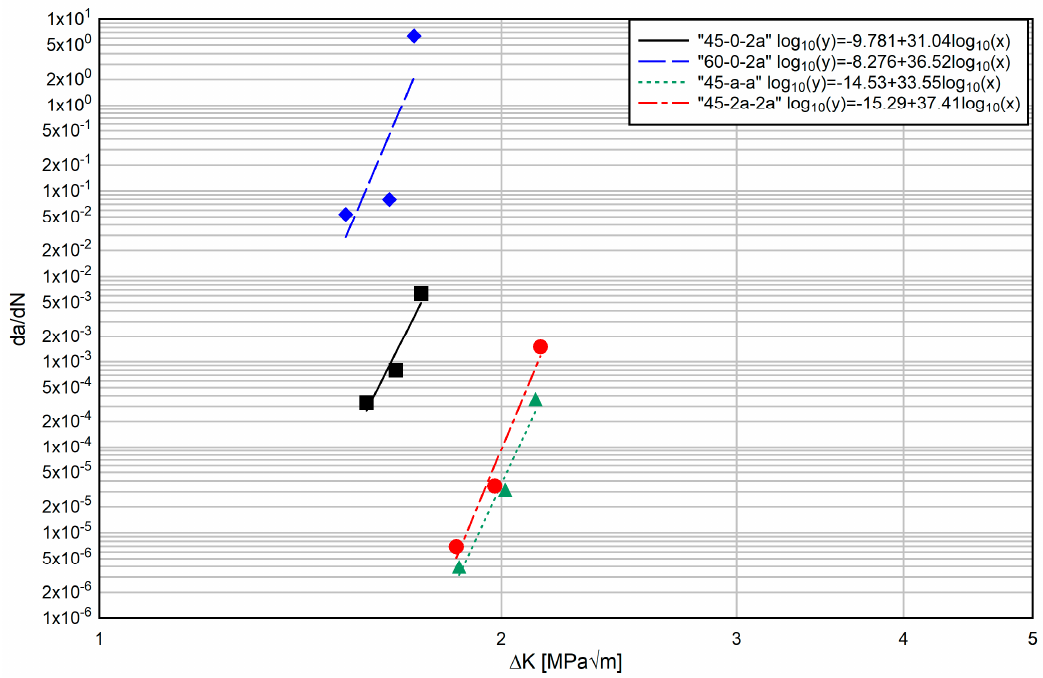
Figure 14. Variation of the rate of crack growth as a function of the stress intensity factor range ∆ K. For the 45-0-2a and 60-0-2a specimens, the subcritical crack growth parameter m values under cyclic loading were 31 and 37, respectively. The subcritical crack growth parameter m values under cyclic loading in the 45-a-a and 45-2a-2a specimens were 34 and 37,